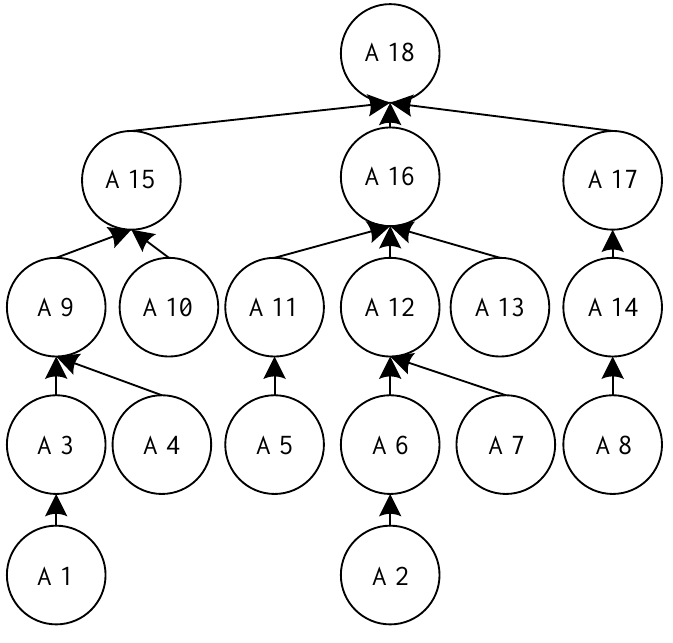
Table 1. The transportation time required for movement of the operation between different ma- chines.